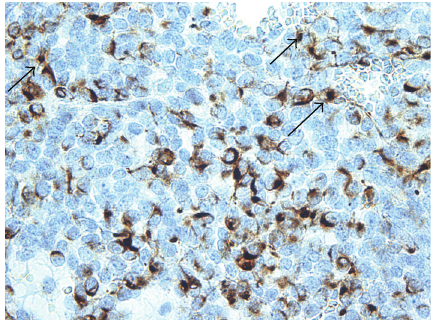
Figure 2: Immunohistochemistry with desmin: perinuclear dot- like staining